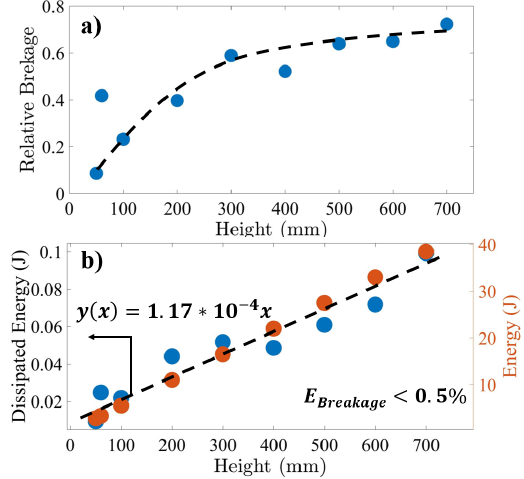
Figure 3. (a) Relative breakage plotted against drop height, (b) energy dissipated by creation of surfaces and total energy from drop tower plotted vs drop height